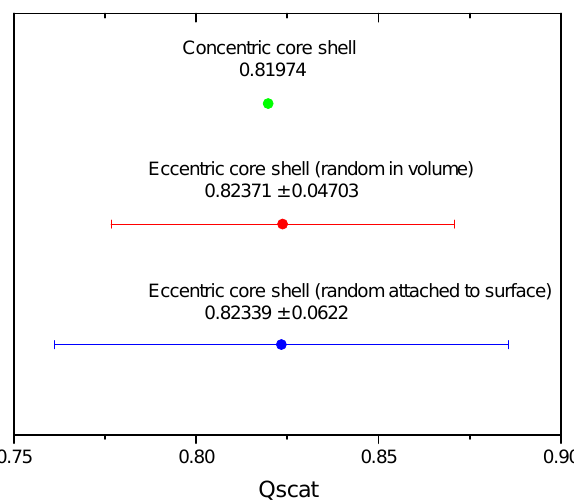
Figure 4. Q scat mean value and standard deviation (SD) for eccen- tric core shell (over 10000 realizations) within the volume (blue), Q scat mean value and SD for eccentric core shell (over 10000 real- izations) randomly attached to the inner surface (red), and Q scat for concentric core shell (green).